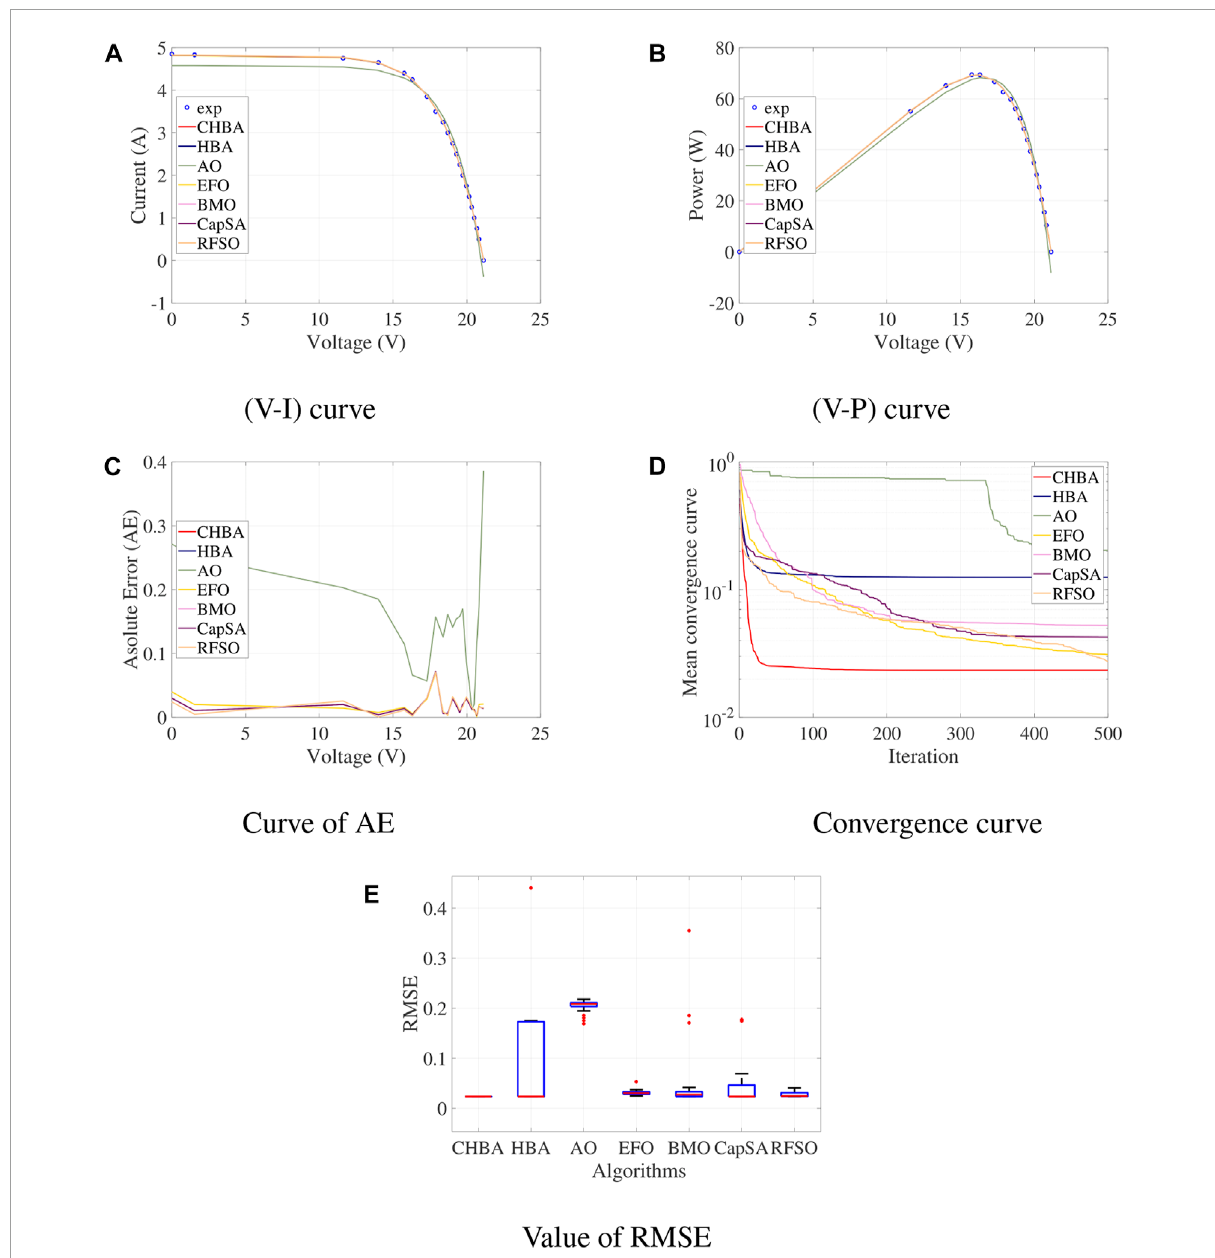
FIGURE 7 Behaviour of competitive techniques using SDM of SLP080 solar